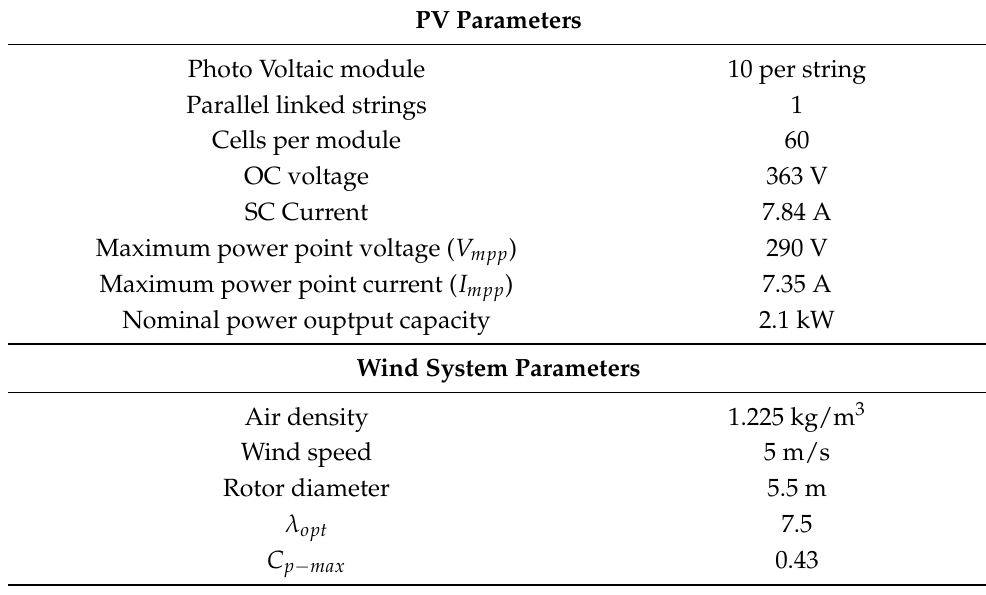
Table 2. Parameters of energy